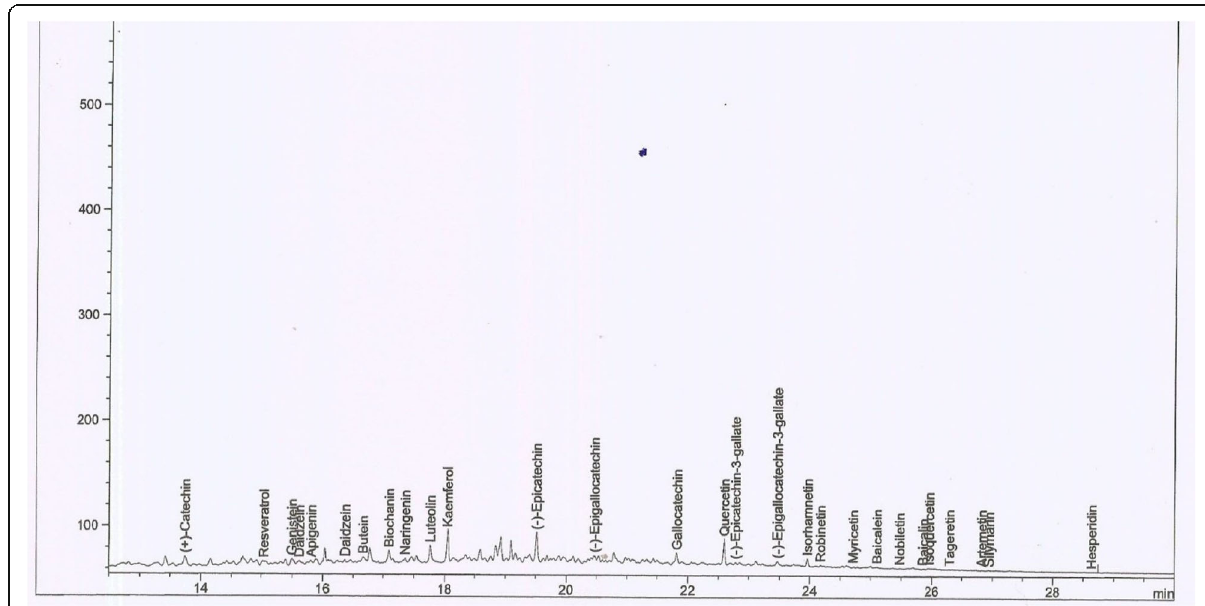
Fig. 1 GC Chromatogram of the “ flavonoid composition ” of ethyl acetate fraction of P . biglobosa leaves